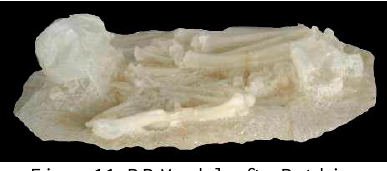
Figure 11. RP Module after Patching